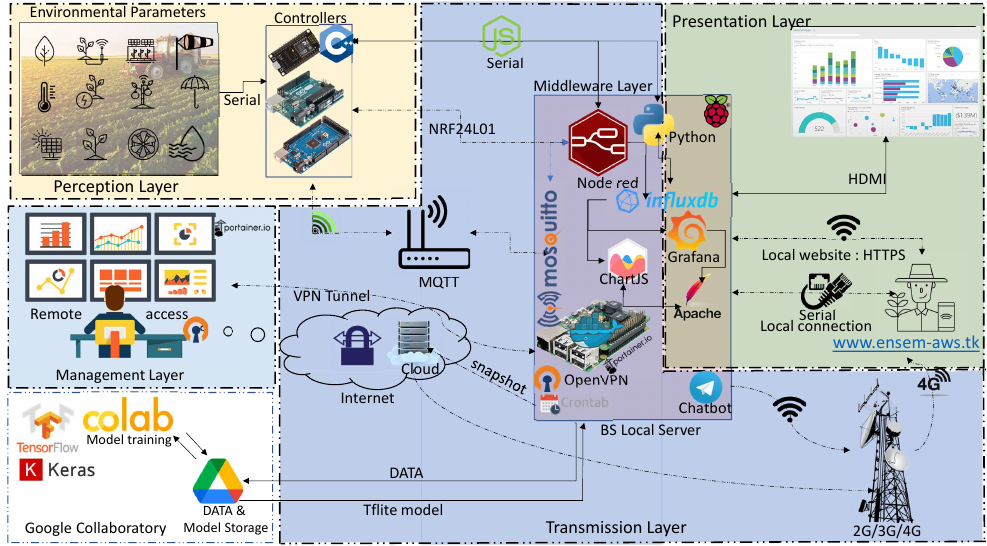
Figure 2. The End-to-End high-level decomposition of the proposed agro-weather